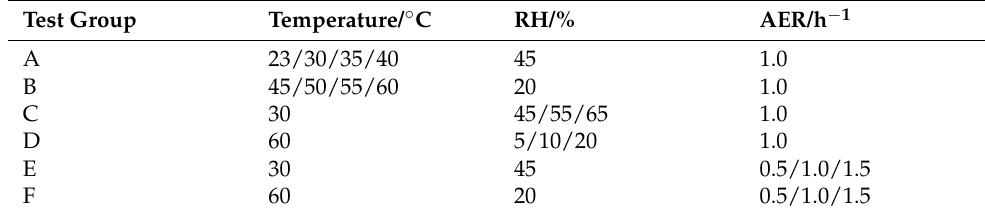
Table 1. Experimental parameters.